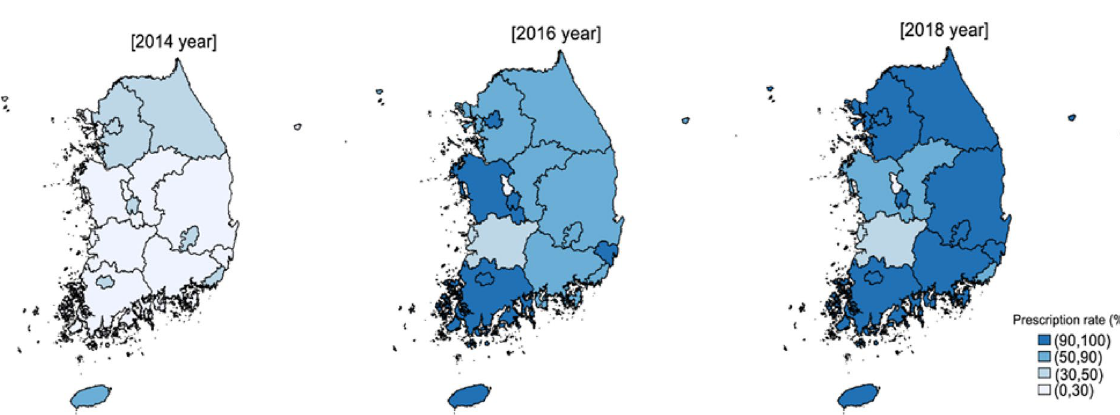
Figure 3. Geographic trends in the prescription rate of single-tablet regimens in South Korea. This represents percentages of single-tablet regimens for treatment- naïve individuals with HIV/AIDS by state: Seoul, Busan, Daegu, Incheon, Gwangju, Daejeon, Ulsan, Sejong-si, Gyeonggi-do, Gangwon-do, Chungcheongbuk-do, Chungcheongnam-do, Jeollabuk-do, Jellanam-do, Gyeongsangbuk-do, Gyeongsangnam-do, and Jeju-do. Maps were generated by KSO with the grmap command in STATA (StataCorp, College Station, TX, USA) and spatial data of Statistics in Korea (https:// sgis. kostat. go.